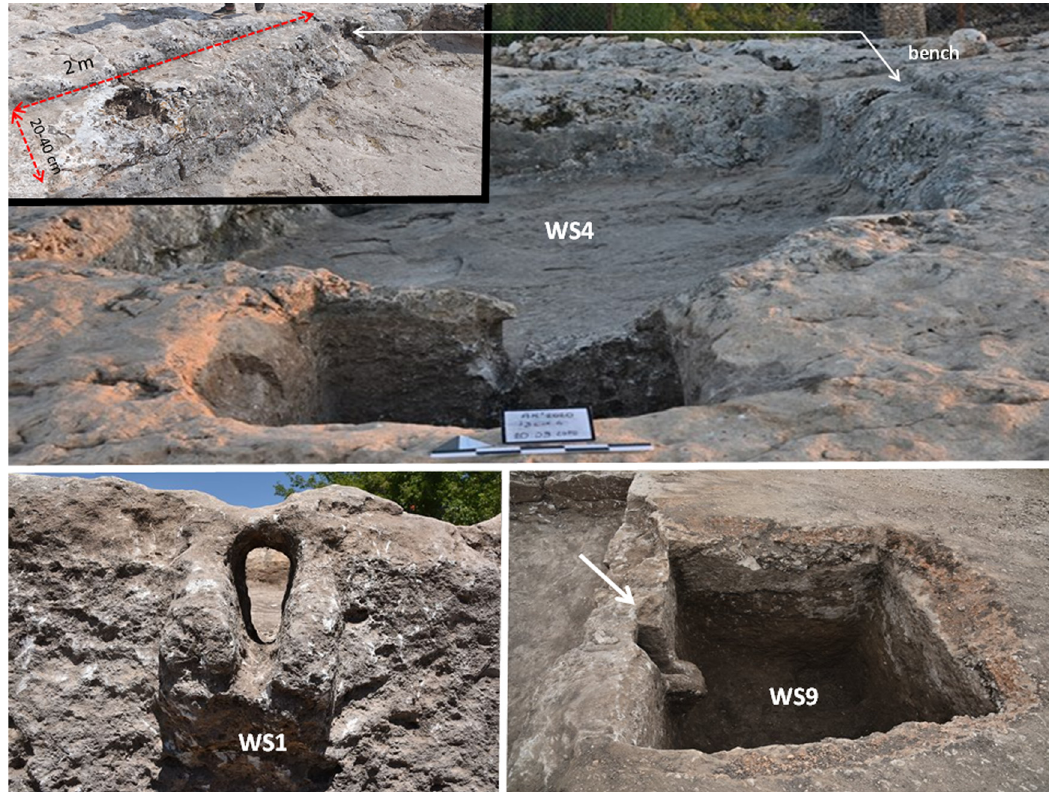
Figure 6: Bench over treading fl oor ( Top ) ; samples of elliptical canals ( Ambarçay Salvage Excavation Archive )